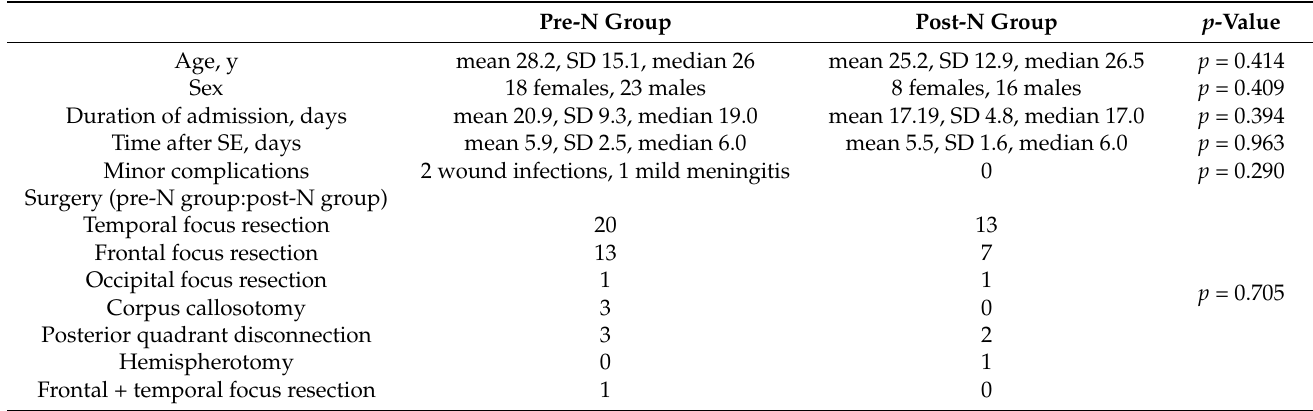
Table 1. Clinical information.